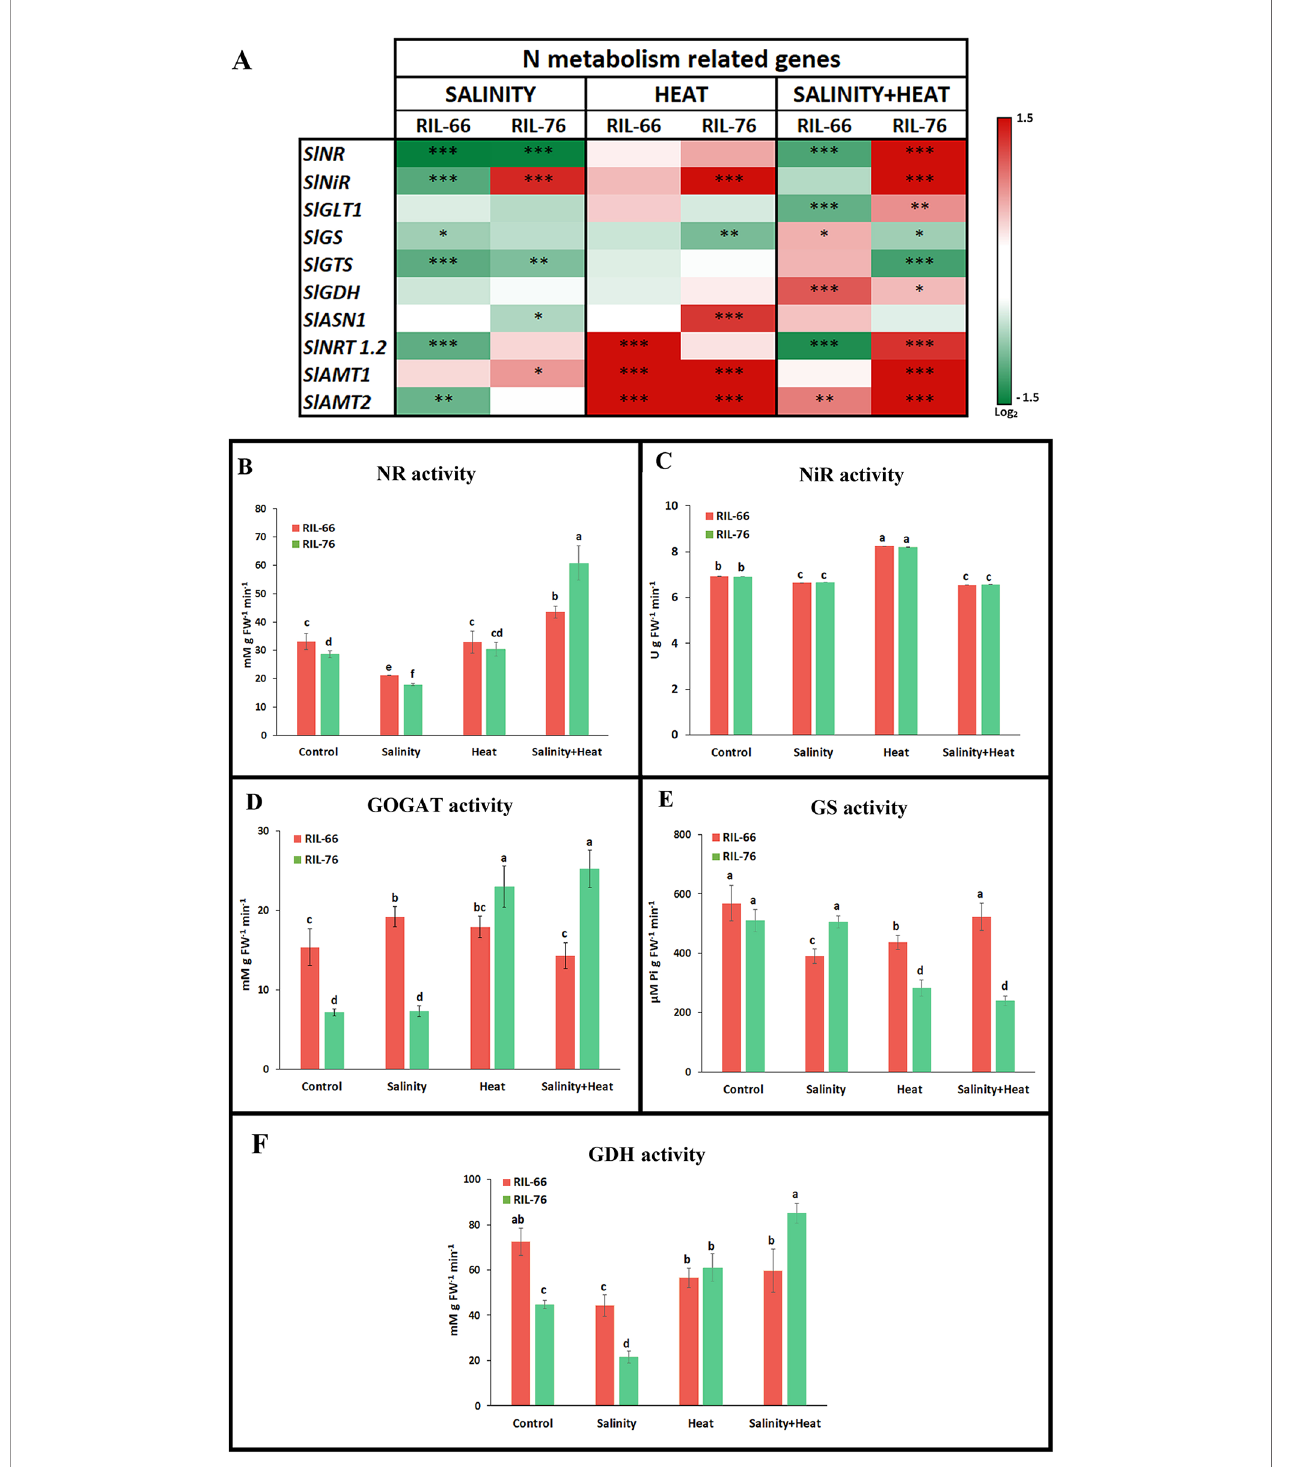
FIGURE 6 | Expression and activities of the genes and enzymes involved in nitrogen (N) assimilation pathway. (A) Heat map of the expression of the N-metabolism related transcripts in leaves of RIL-76 (salt + heat tolerant) and RIL-66 (salt+heat sensitive) under salinity, heat, or the combination of salinity and heat. Scale is log 2 of the mean values after normalization against control plants (n= 6). Asterisksare representative of signi fi cant differences atp < 0.05 (*p < 0.05; **p < 0.01; ***p < 0.001). (B – F) Absolute activities of theN-assimilation pathway related enzymes inrecombinant inbredline (RIL)-66 and RIL-76 under control, salinity,heat, or the combination of salt +heat. Barsare mean values ± SE (n = 6),and barswith different lettersare signi fi cantlydifferent at p < 0.05 according to Tukey's test. (n=